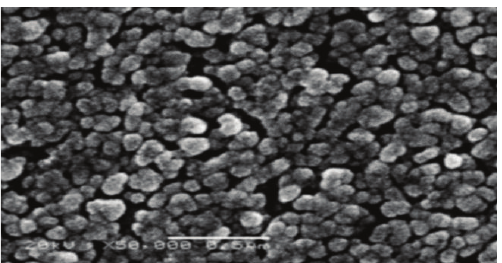
Figure 3: SEM image of the morphology of the one-layer printed silver nanoparticles ink on paper.